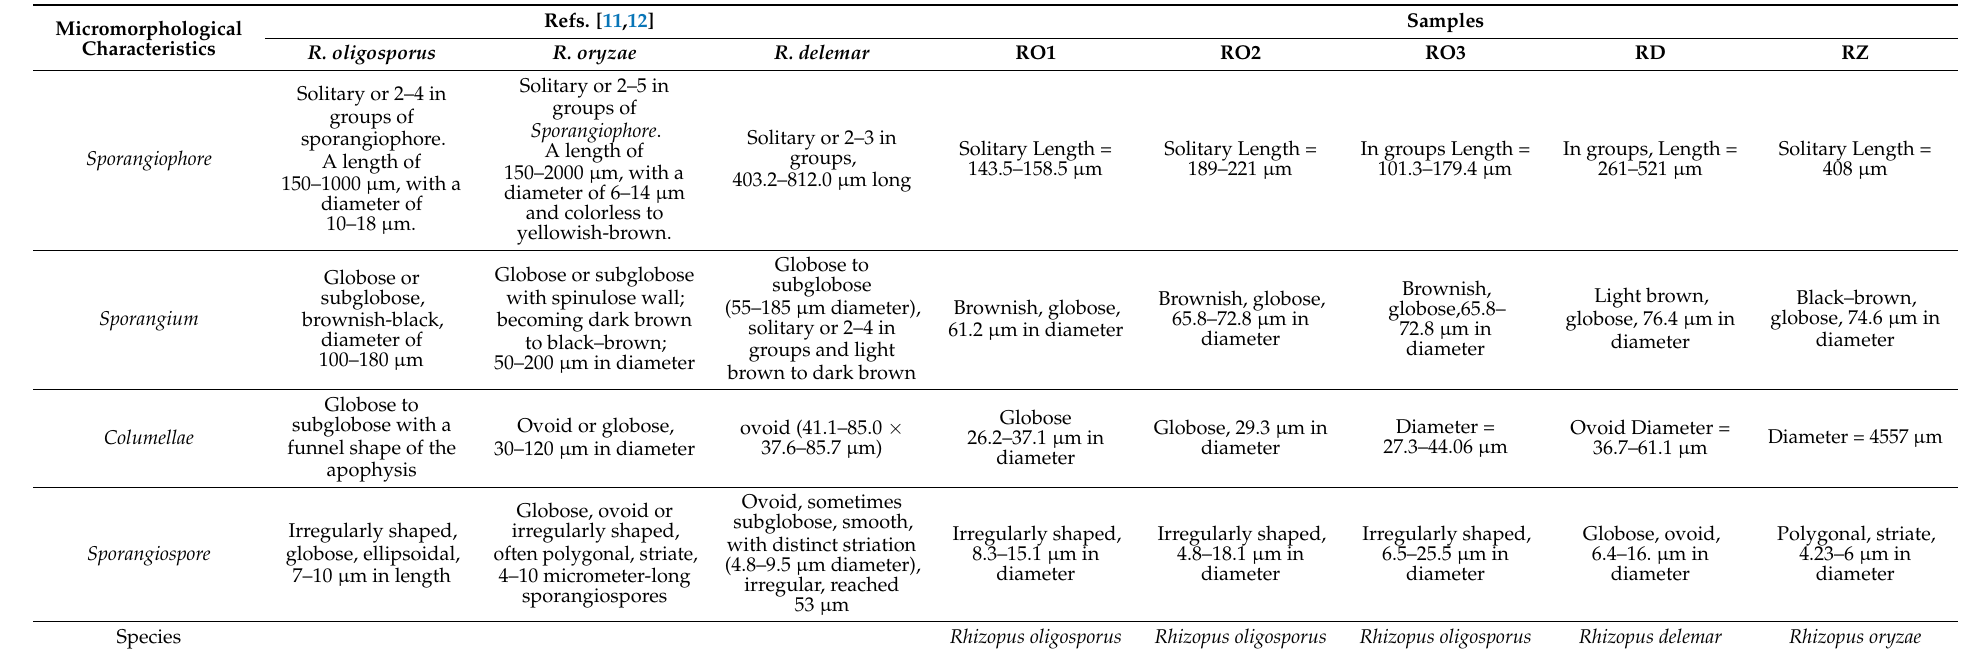
Table 1. Morphological identification of five local isolates of Rhizopus